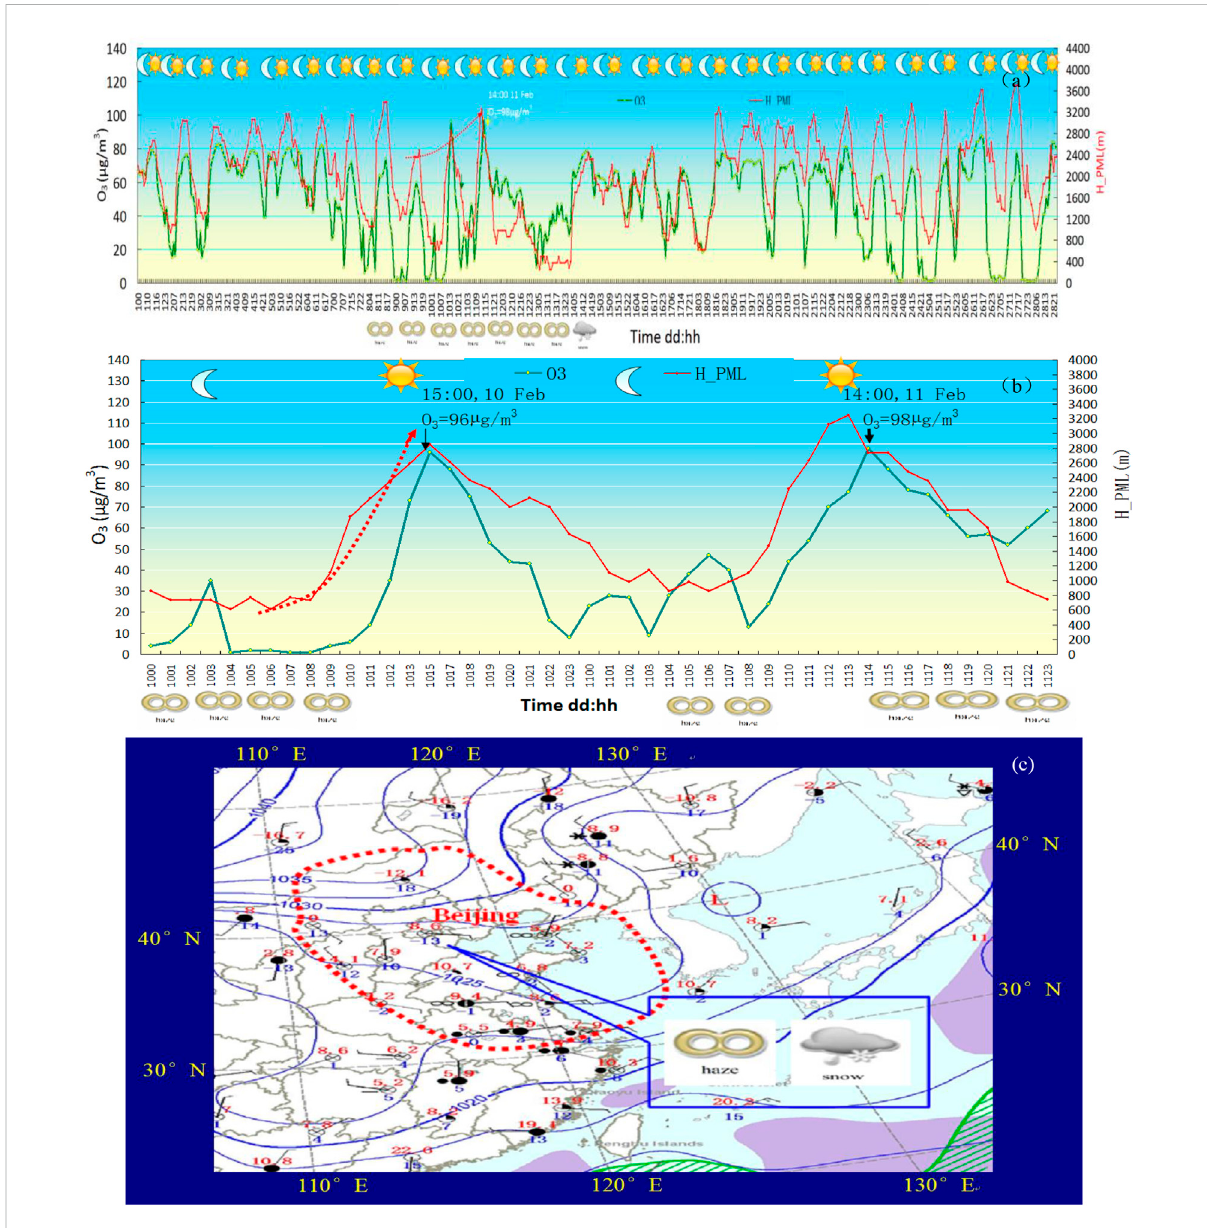
FIGURE 2 (A) Hour-by-hour O 3 and H_PML changes in February 2022 in Beijing, (B) hour-by-hour detailed distribution of O 3 and the height of H_PML fl uctuations from December 10 – 11 in (A) , and (C) ground weather map at 14:00 (BJT) on February 11 in